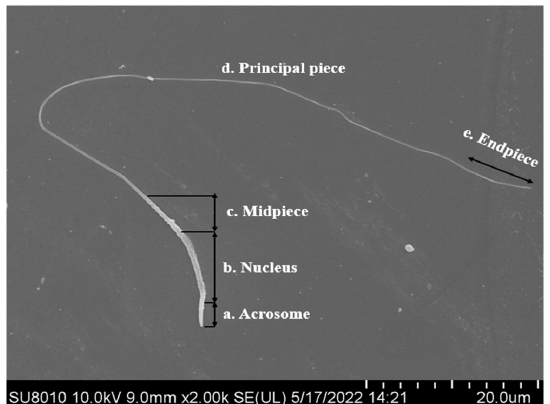
Figure 1. The structure of chicken sperm (scanning electron microscope, Hitachi SU8010, Japan. Scale bar = 20 um at 10,000× magnification).